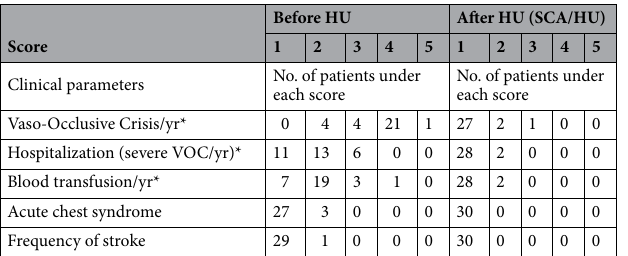
Table 2. The changes in Clinical parameters in terms of scores of HbS homozygous patients at baseline and after HU therapy (3- and 6-months’ time point denoted as SCA/HU). *: p <0.00001, before and after HU